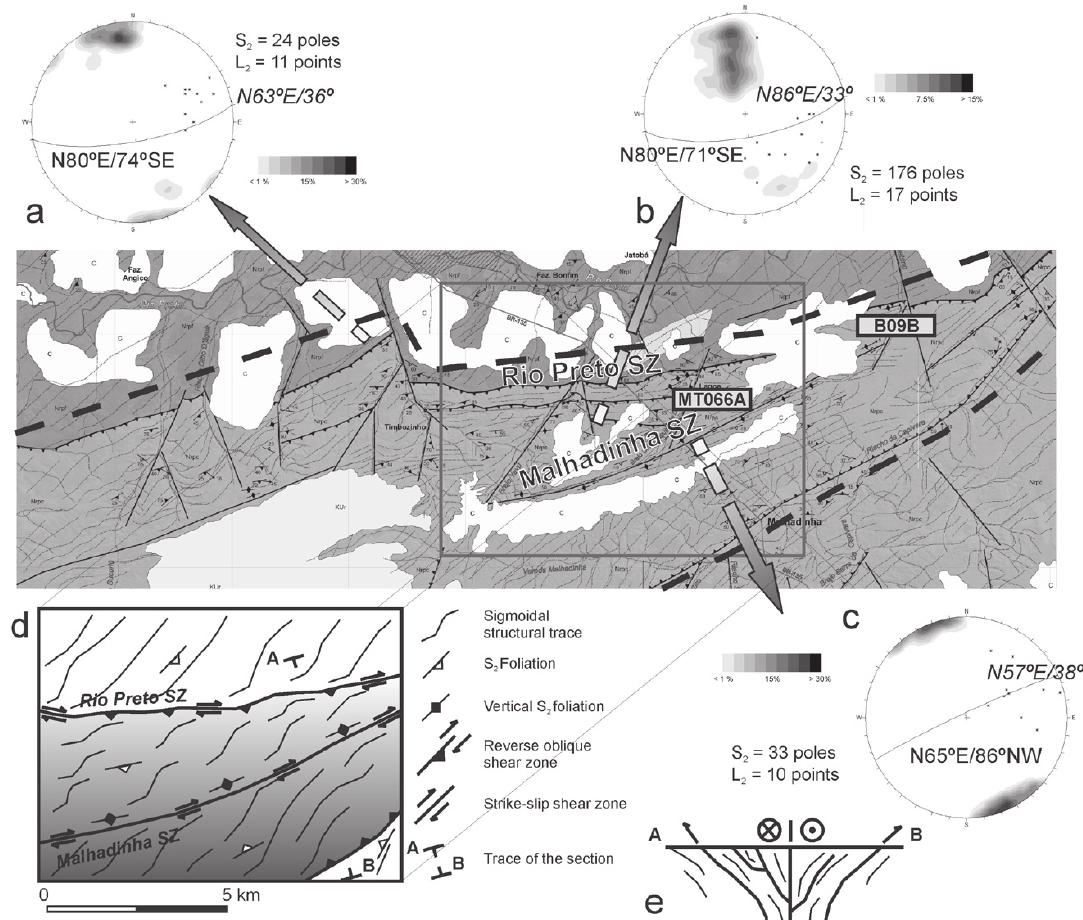
Figure 6 - Isoareal stereograms for structures in a) Rio Preto Shear Zone; b) central portion of the Central Compartment; c) Malhadinha Shear Zone. In d) and e) , structural schemes of the Central Compartment, in plane and section view,